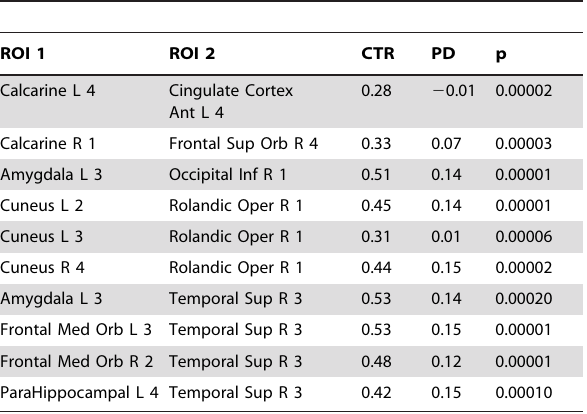
Table 5. Altered connectivity of left cuneus node with significant between-group